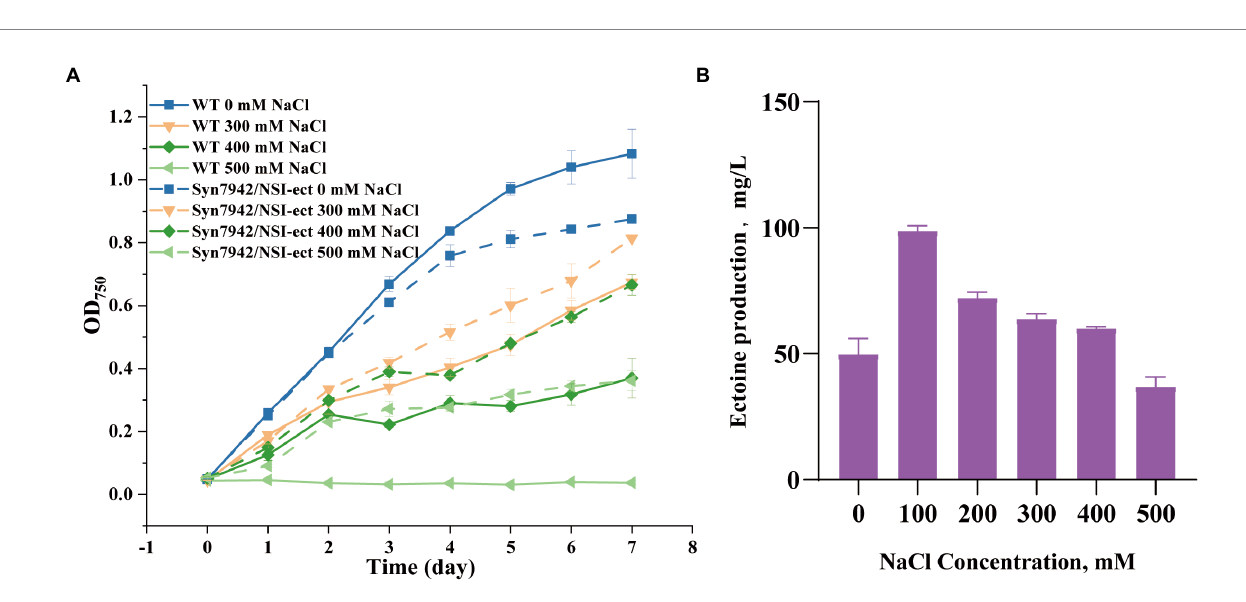
FIGURE 2 Growth curves and ectoine production of WT and Syn7942/NSI-ect. (A) Growth curves of WT and Syn7942/NSI-ect under 0, 300, 400, 500 mM NaCl; (B) Ectoine production of Syn7942/NSI-ect under 0, 100, 200, 300, 400, 500 mM